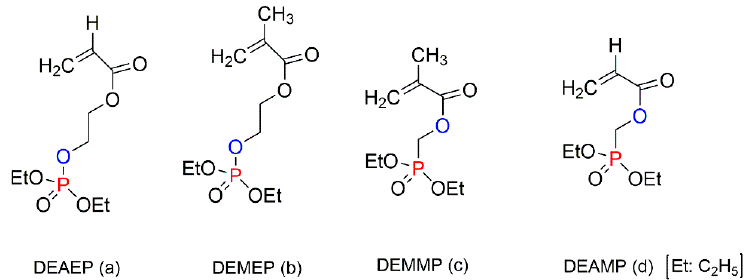
Figure 19. Chemical structures of unsaturated phosphates and phosphonates [38].